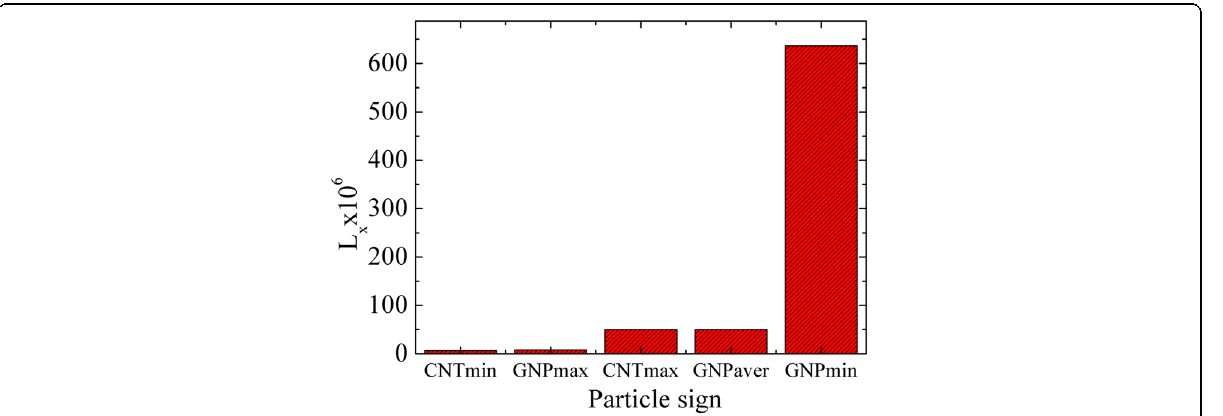
Fig. 7 Depolarization factor for GNPs and MWCNTs evaluated by Eqs. (2) and (3)